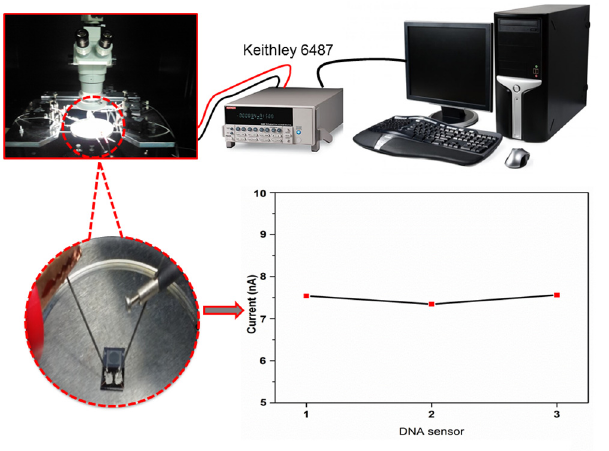
Fig 4. Experimental set-up of picoammeter for the TiO 2 nanoparticle-based DNA biosensor. Current responses show ability of the device to retain the same output current after hybridization and dehybridization of 1 μ M targeted